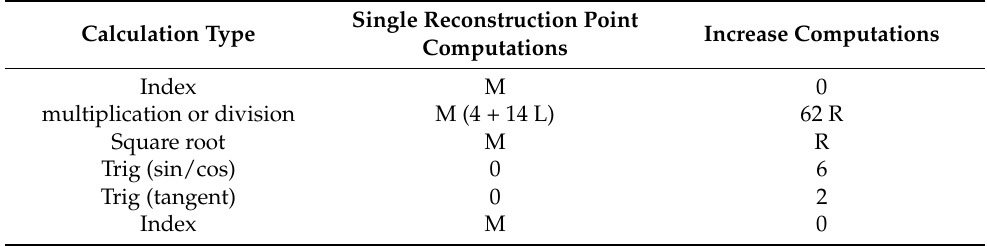
Table 1. Computational complexity of single reconstruction point and the increase of combining stereo